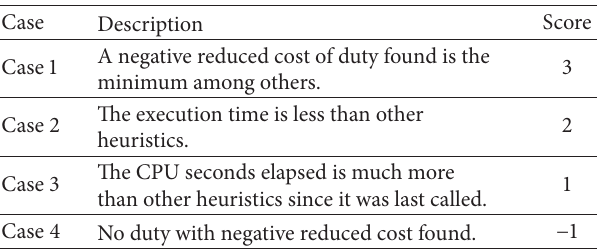
Table 1: Reward in the particular